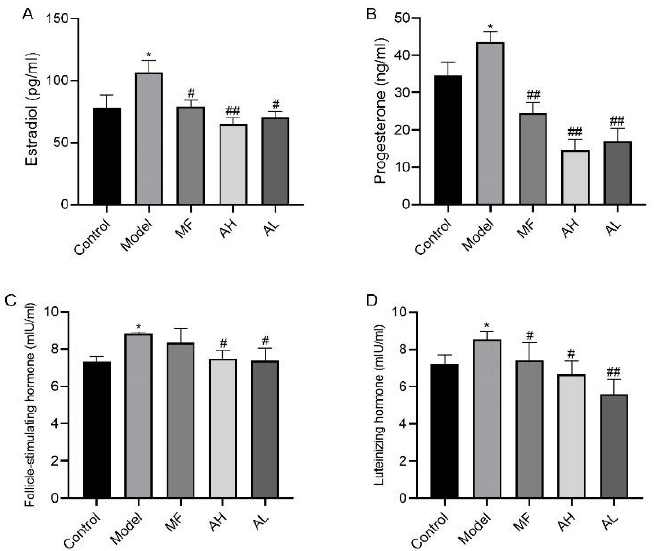
Figure 9. Determination of serum neutral hormone levels in rats by radio immune assay (RIA). ( A ) Estradiol. ( B ) Progesterone. ( C ) Follicle-stimulating hormone. ( D ) Luteinizing hormone. The data are presented as the mean ± SD ( * p < 0.05, compared with the control group; # p < 0.05, ## p < 0.01 compared with the model group).